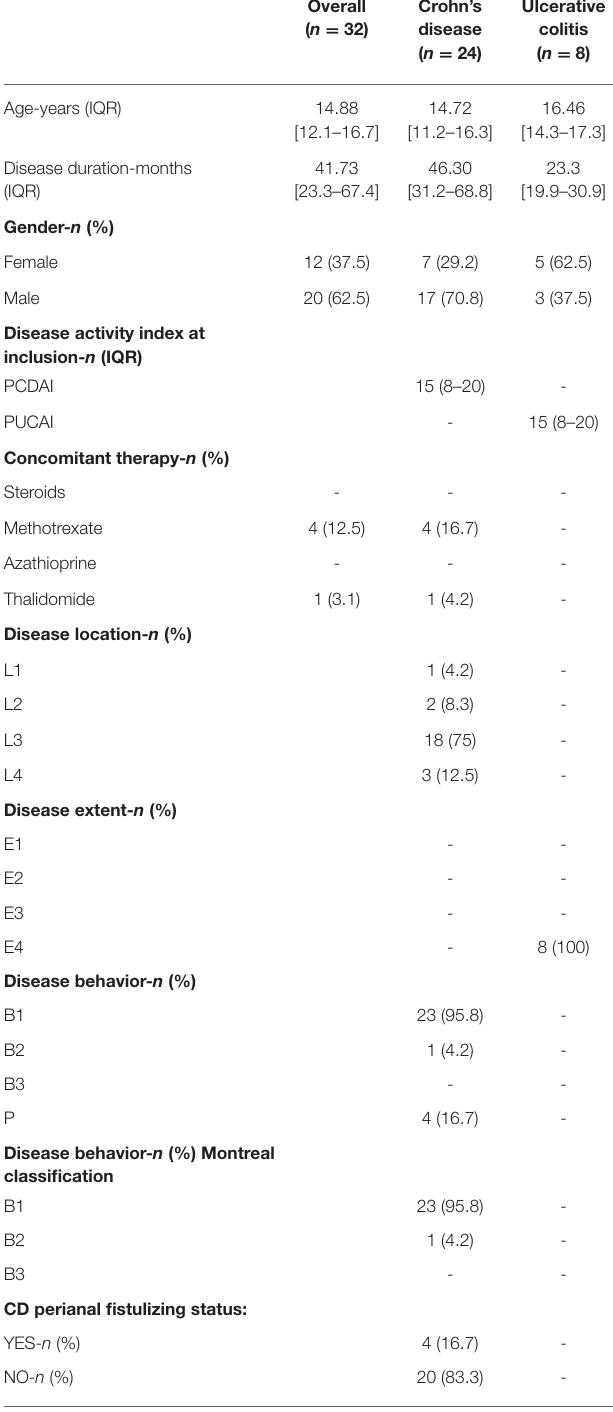
TABLE 1 | Demographic and clinical characteristics of the population